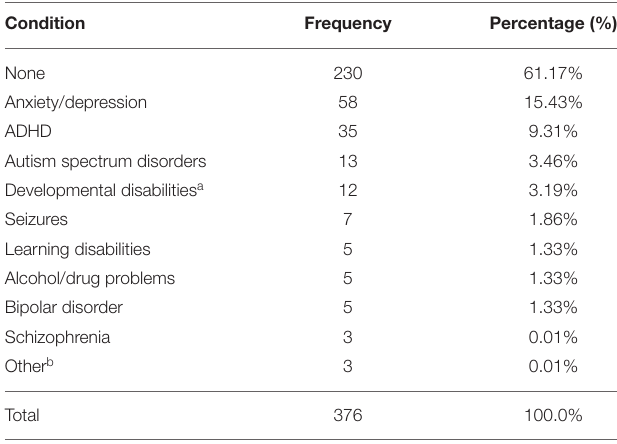
TABLE 1 | Developmental or mental health conditions of mothers’ biological